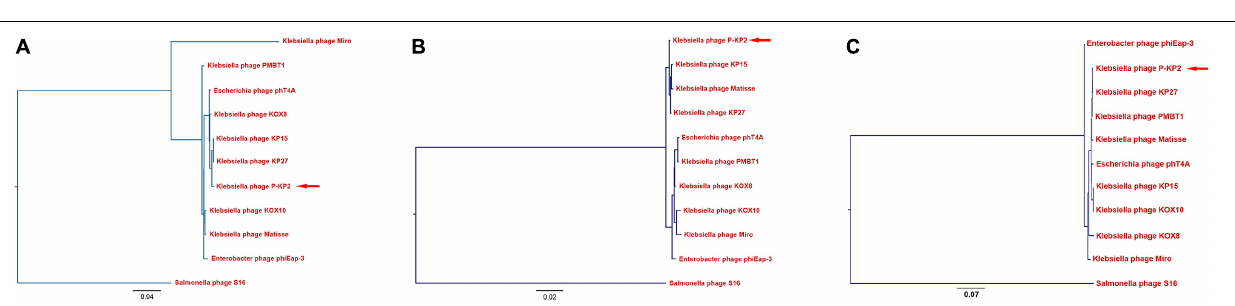
FIGURE 4 | Phylogenetic analyses of P-KP2 and homologous phages. (A) Phylogenetic tree based on terminase large subunit genes. (B) Phylogenetic tree based on genes of major capsid protein. (C) Phylogenetic tree based on genes of DNA polymerase. These sequences were compared using ClustalW, and the